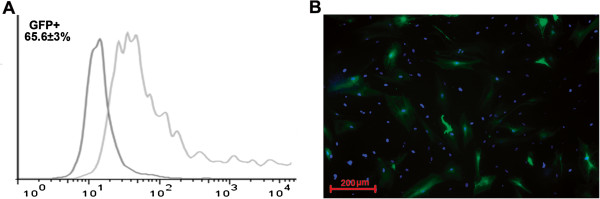
Human ADSC transduction by recombinant adeno-associated virus. A. GFP-positive cell count by FACS in GFP-ADSC culture at day 4 after transduction by rAAV. B. Representative image of GFP-positive human ADSC (green) transduced by rAAV, 100 × magnification. Cell nuclei are counterstained by DAPI. Data obtained from a total of 10 donors.